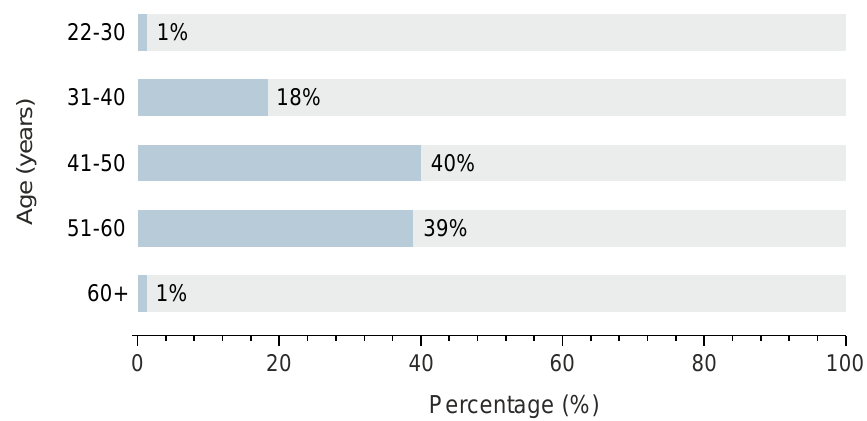
Figure 1. Age composition of teachers interviewed (percentages do not sum to 100 due to round- ing).